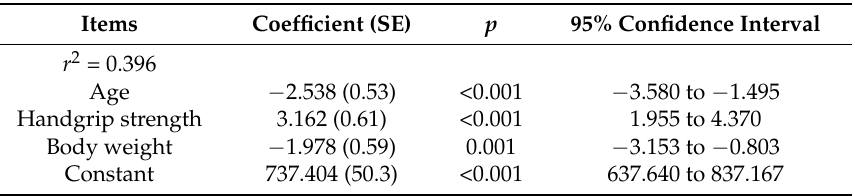
Table 3. Predicting model for 6MWT distance.